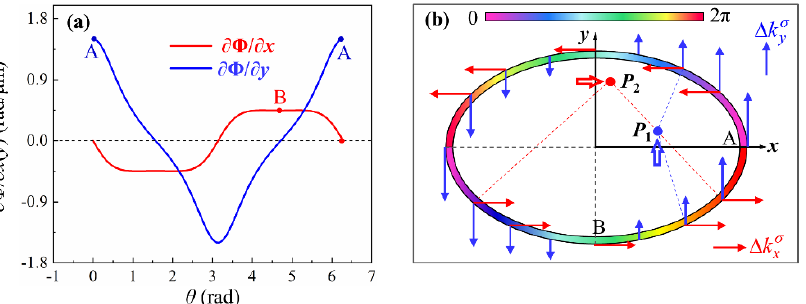
Figure 2. ( a ) Geometric phase gradients at different positions (different θ ) on the elliptical nanoslit. ( b ) Schematic diagram demonstrating the shifts of the characteristic spots P 1 and P 2 due to geometric phase gradients ∂ y Φ and ∂ x Φ , respectively; the color bar represents the geometric phase.